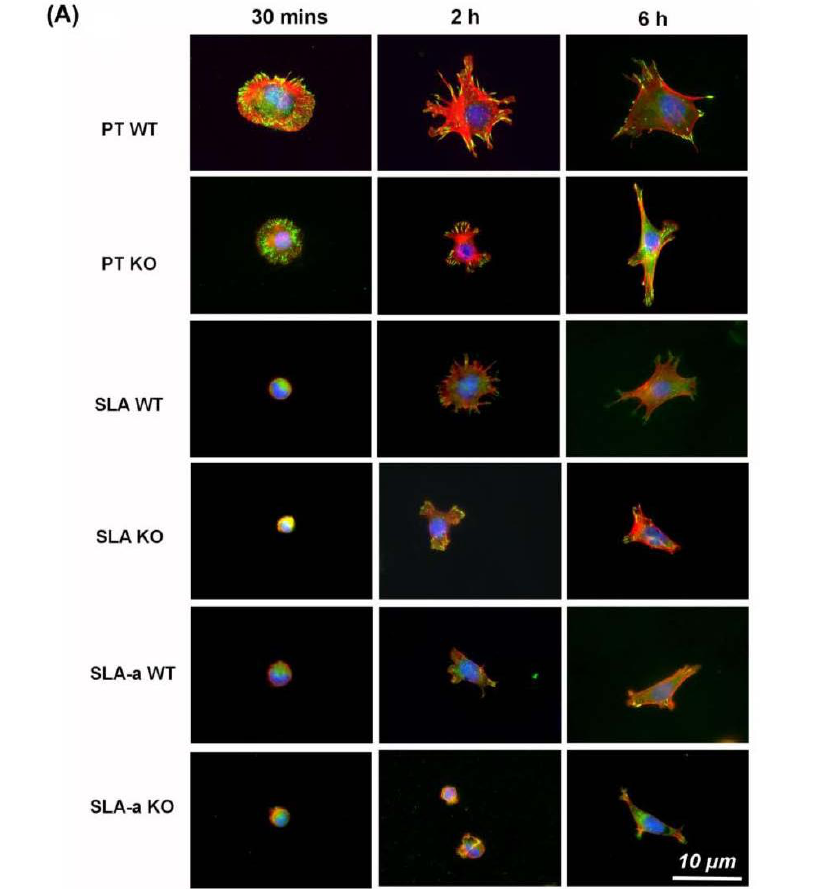
Figure 3. Influence of substratum topography and hydrophilicity on spreading and adhesion formation of FAK −/− and WT fibroblasts. In ( A ), cells were labeled with antibodies to vinculin (green) to visualize focal adhesions and counterstained with rhodamine-phalloidin (red) to visualize F-actin; ( B ) Spreading (planar area) of fibroblasts cultured on PT, SLA and hydrophilic SLA 30 mins, 2 and 6 h post-seeding. Data were analyzed for statistical significance using 2-way analysis of variance (ANOVA) with Bonferroni test. * = significance ( p < 0.05) between KO vs. WT, and # = significance between SLA and hydrophilic SLA vs . PT ( p <